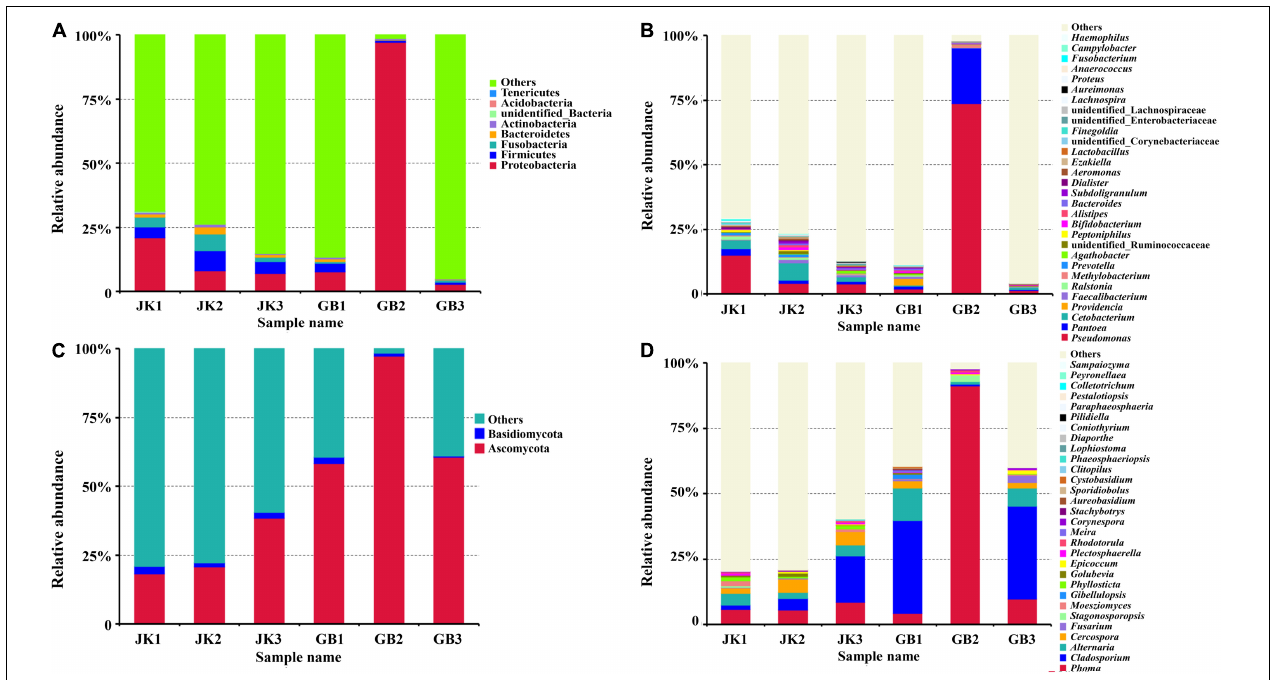
FIGURE 2 | Microbial community composition of different samples (asymptomatic leaves JK1, JK2, JK3; symptomatic leaves GB1, GB2, GB3) at the phylum [ (A) for bacteria, (C) for fungi] and genus [ (B) for bacteria, (D) for fungi] levels. The relative abundance of phyla or genera making up less than 0.01% were classified as